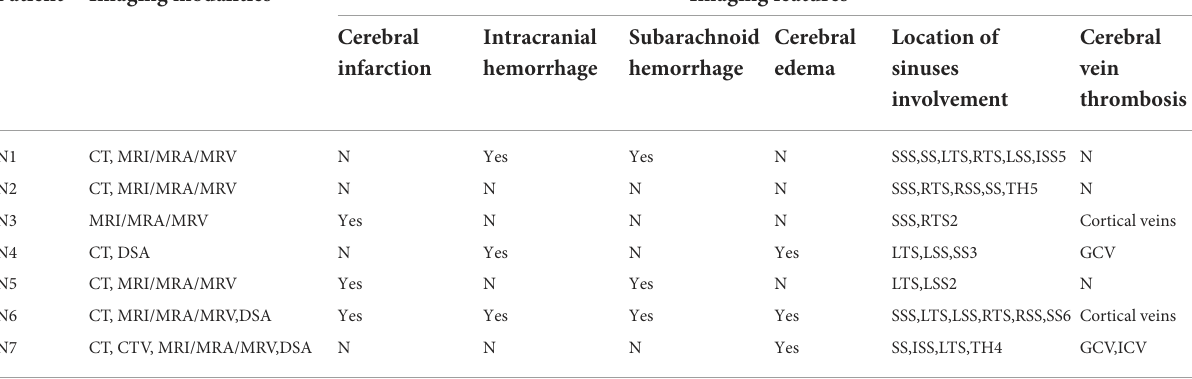
TABLE 3 Neuroimaging features of the included patients with CVT.